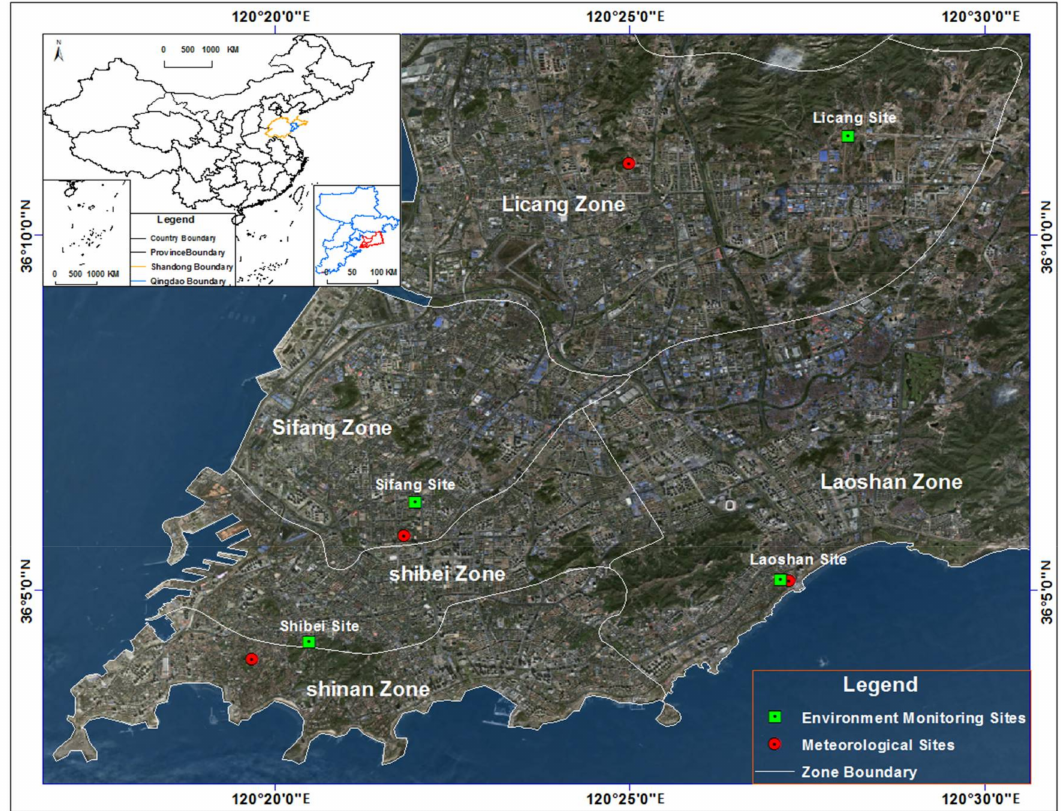
Figure 2. Maps of study area, monitoring sites, and geomorphic